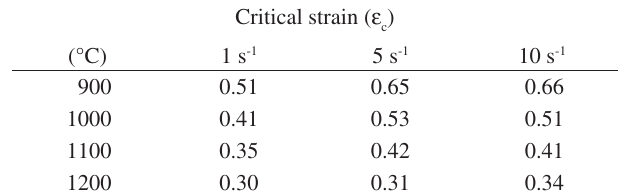
Table 2. Evolution of the critical strain causing the onset of dynamic recrystal- lization under the deformation conditions employed here.